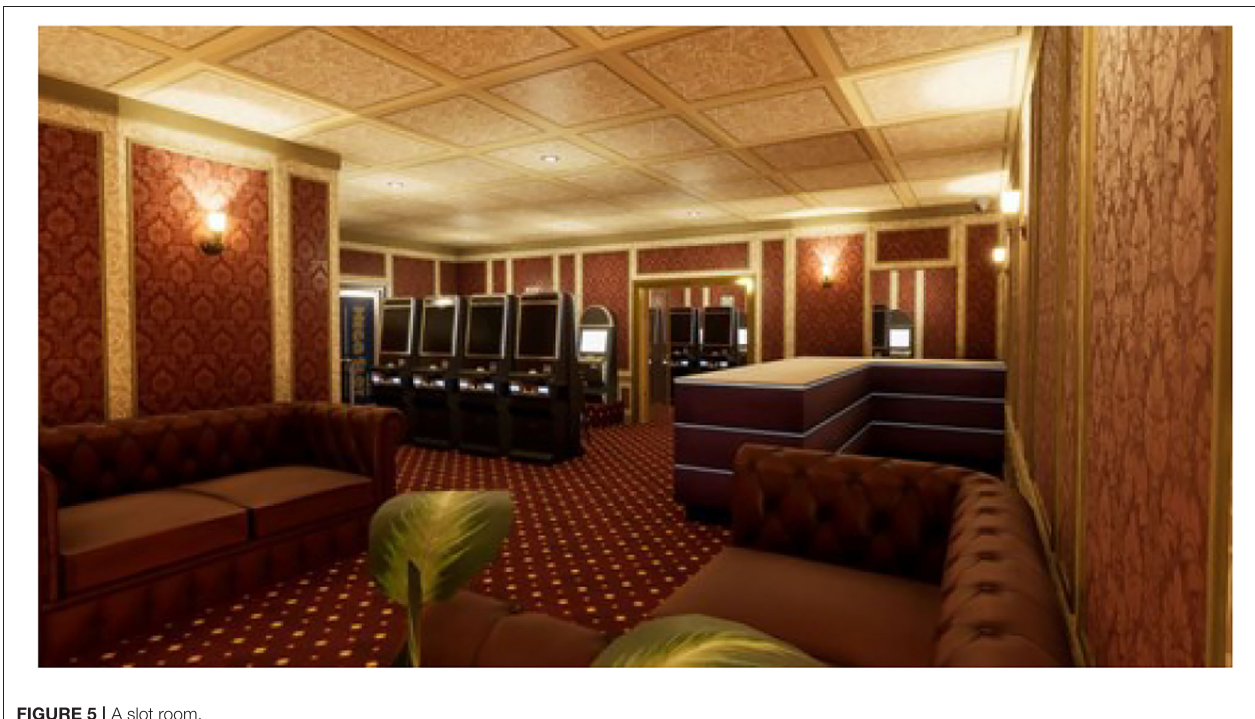
FIGURE 5 | A slot room.